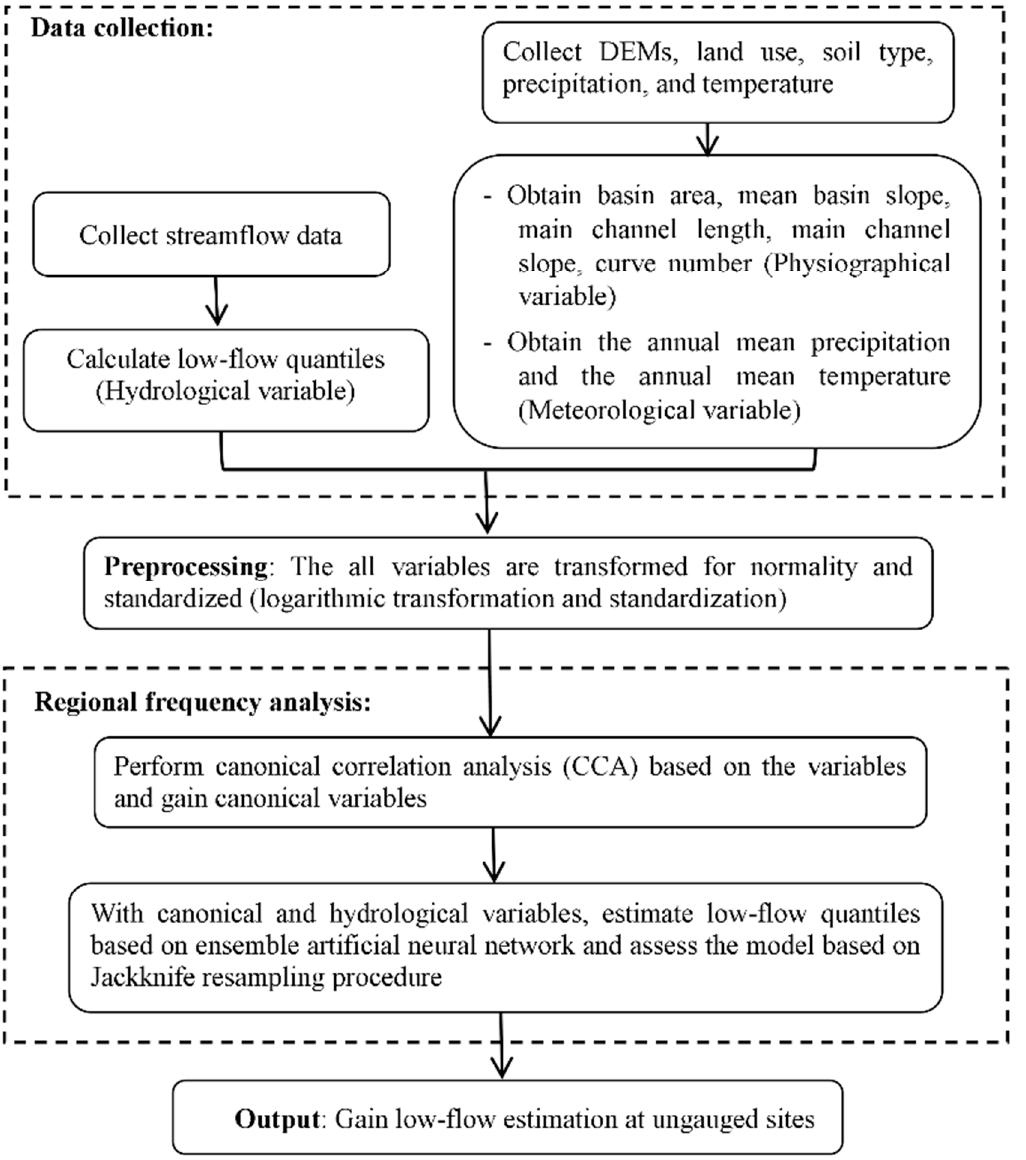
Figure 3. Diagram of the processes that were used to obtain the low-flow estimates at ungauged locations based on regional frequency analysis.